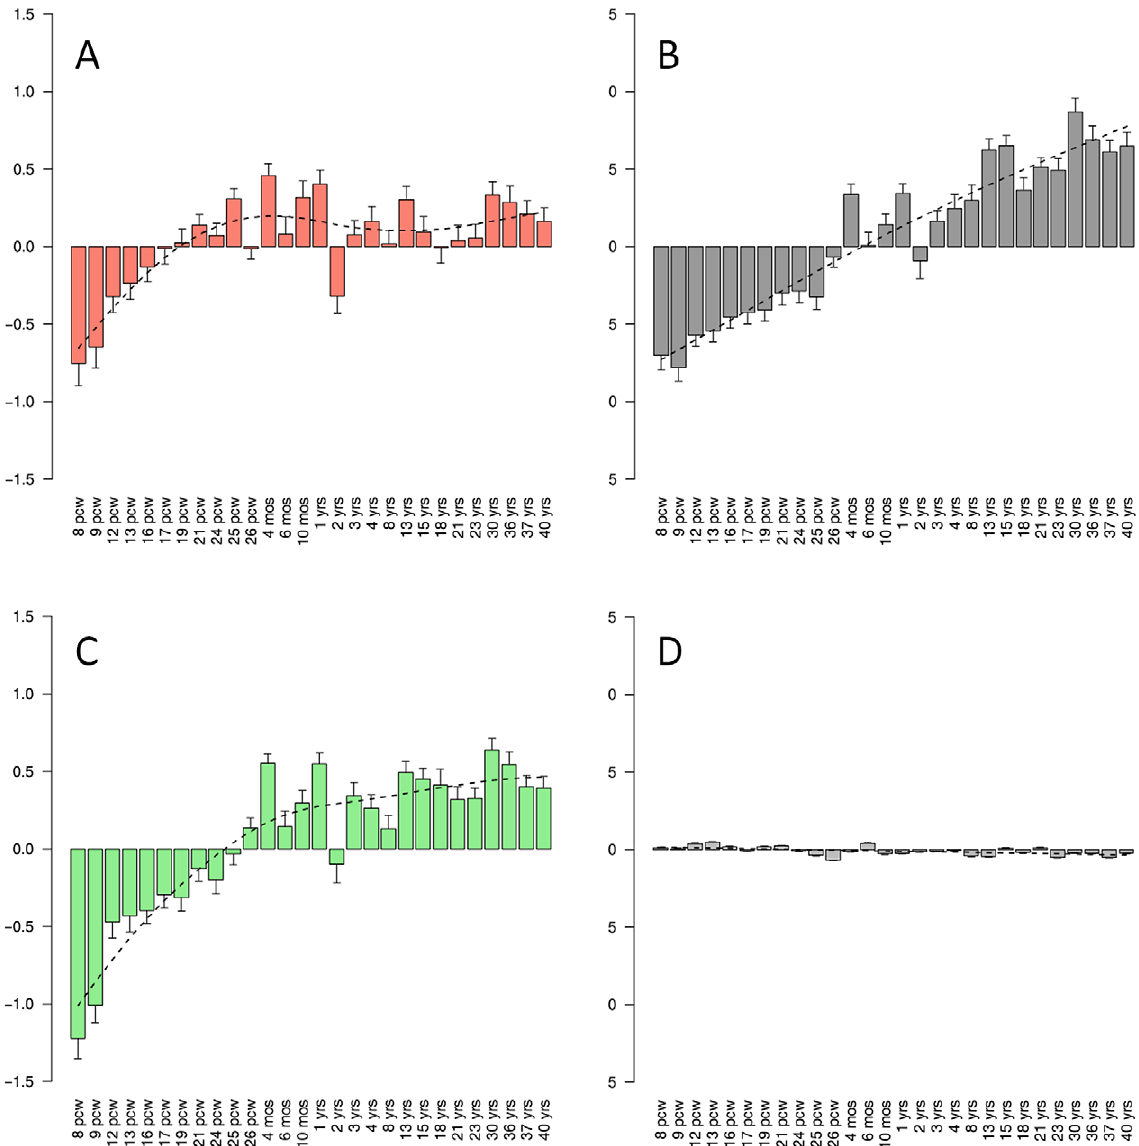
Figure 5. Expression of neuronal modules during developmental stages. The temporal expression pattern is plotted for the modules Salmon (A), Grey60 (B) and Lightgreen (C), along with the pattern of the entire gene set (D). For each module, the average normalized expression across different brain regions for the 50 most connected genes is shown in different ages, overlaid by a smoothed signal (dashed line). pcw, post- conceptional weeks; mos, months; yrs,